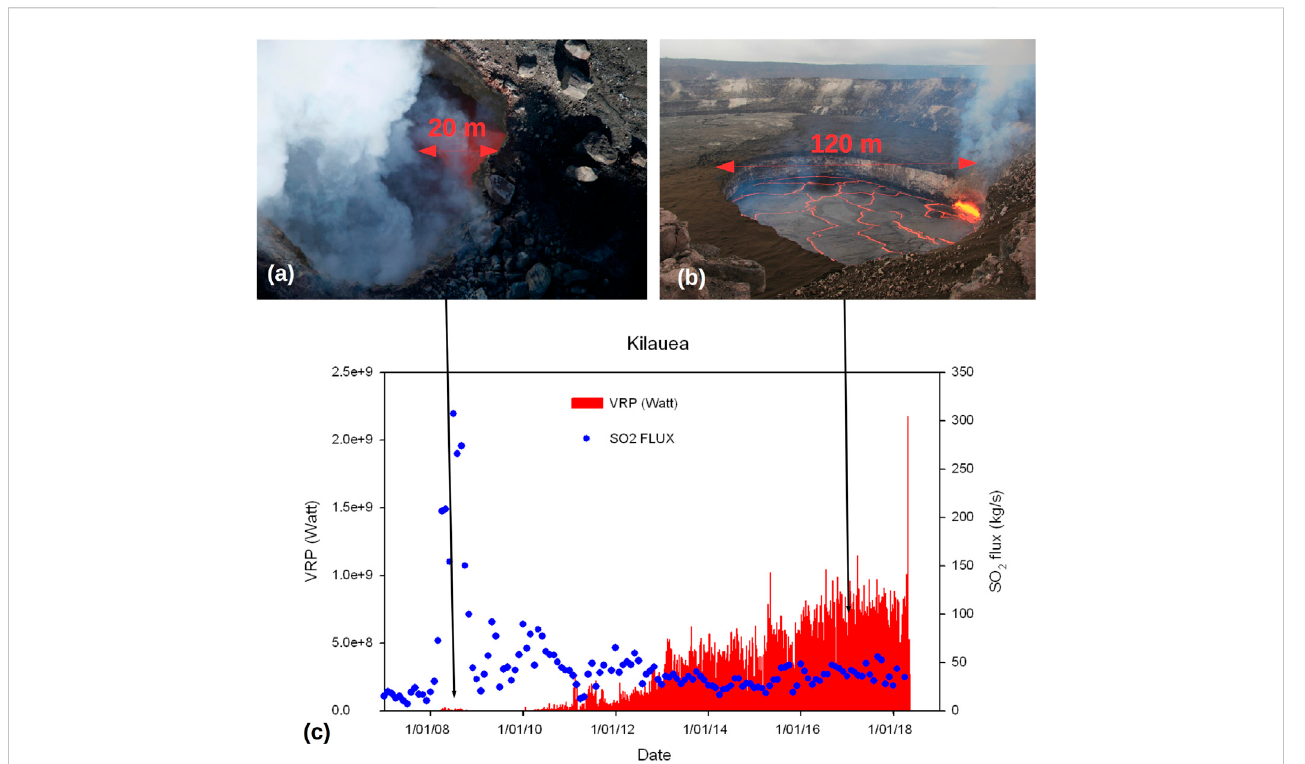
FIGURE 5 (A) NarrowcollapsepitinHalemaumaucratercontaininganembryoniclavalakeofKilaueainMay2008(photo:USGS). (B) ViewofthematurelavalakeinOctober 2017(photo:USGS). (C) TimeseriesoftheSO 2 fl uxanddailyVolcanicRadiativePowerfromKilaueavolcano.TheSO 2 fl uxof10 – 25 kg/sbeforetheformationofthelava lake in Halemaumau crater in 2008 was almost entirely emitted from the long-lasting Pu ’ u O ’ o effusive eruption in the East Rift Zone of the